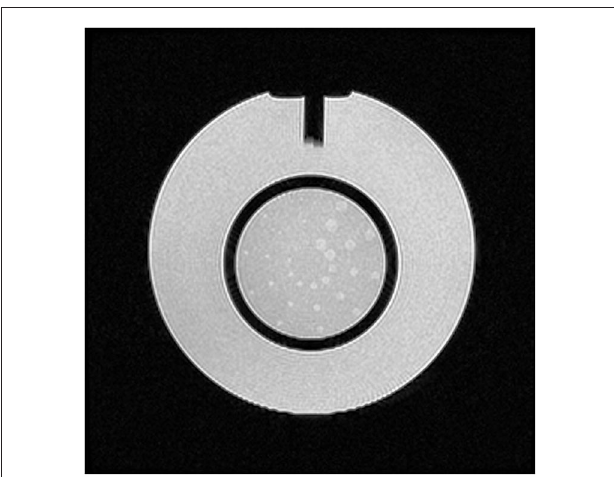
FIGURE 6 | Slice 22, with low-contrast objects of varying size and contrast for the “Low-contrast object detectability” test.